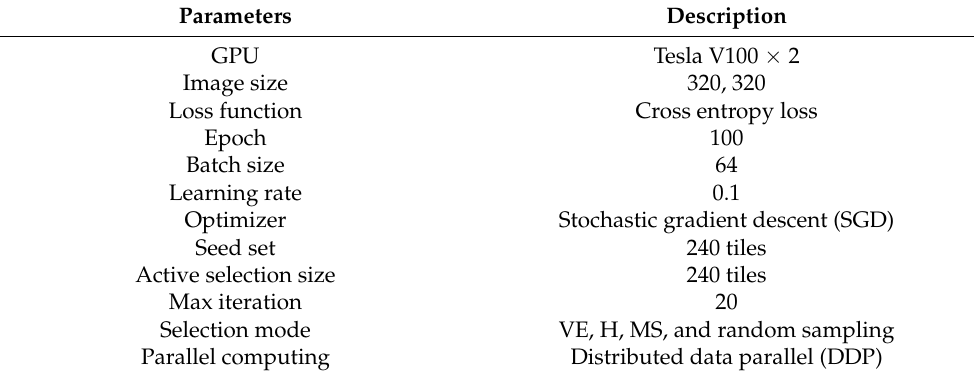
Table 2. Experiment parameters used in the